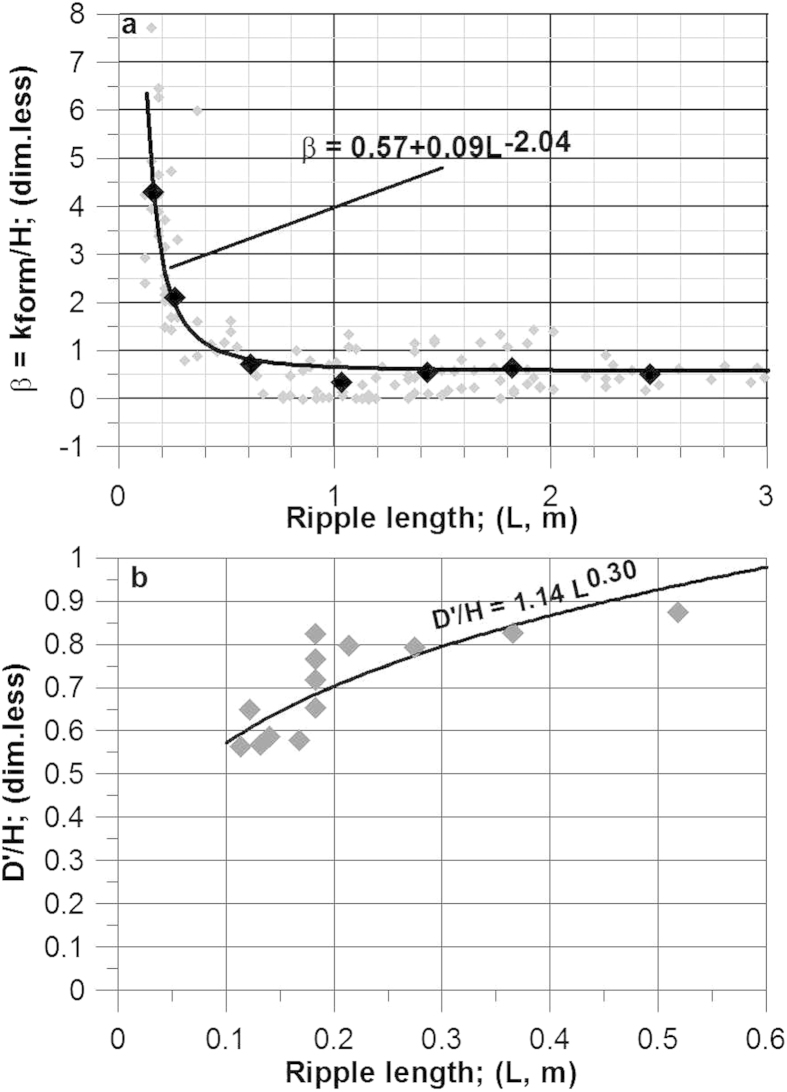
Calibration results forming the basis of the presented model.a) Relation between bedform length and β (see text). The data are from13 (8-foot-wide flume with L < 3 m). The regression relates to mean values (black symbols) calculated for the following intervals (in m): L = 0.1–0.2; 0.2–0.4; 0.4–0.8; 0.8–1.2; 1.2–1.6; 1.6–2.0; 2.0–3.0. The regression correlates with a coefficient of determination of R2 = 0.99.The small gray symbols represent the whole data set for L < 3 m. b) Values of D′/H plotted against ripple length. The regression correlates with a coefficient of determination of R2 = 0.65.The datasets are from131415. Only datasets with D/d > 1000 were used. The data sets from1415 were reduced to represent the smallest and largest current velocity at which ripples were present in the flume.